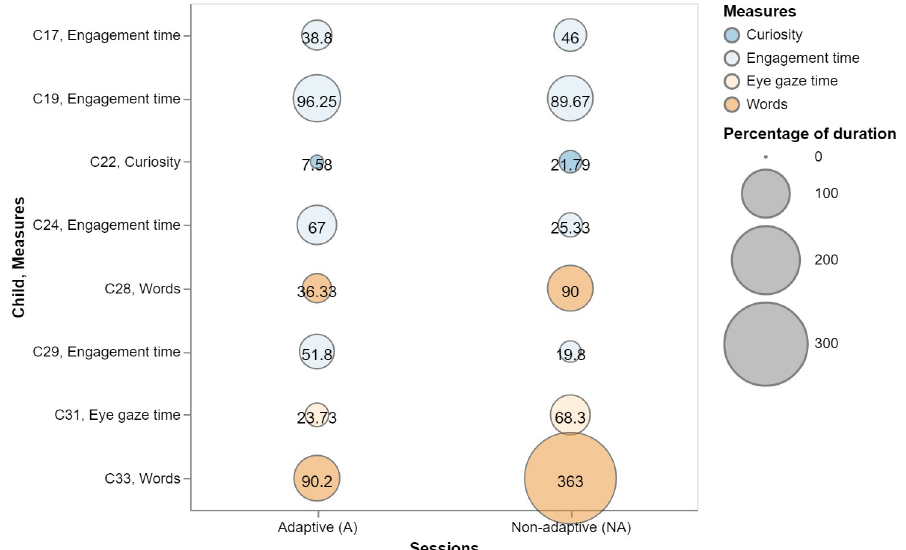
Figure 5. The significant differences of individual analyses across adaptive and non-adaptive sessions. n for p <